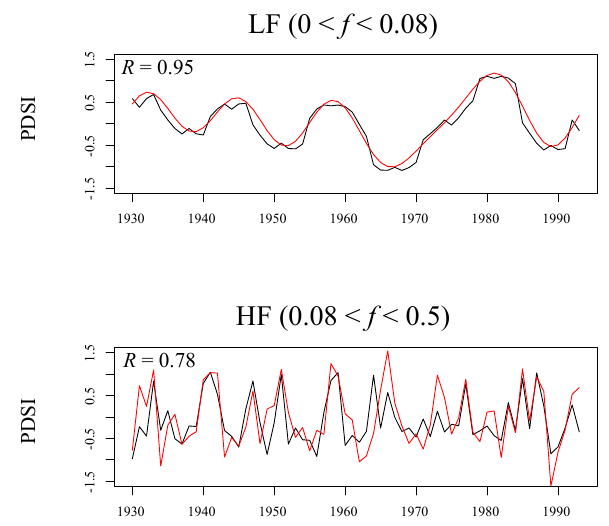
Fig. 4. The 1930–1993 LF and HF components of the summer PDSI in SSA. Observed and reconstructed values are in red and black, respectively.